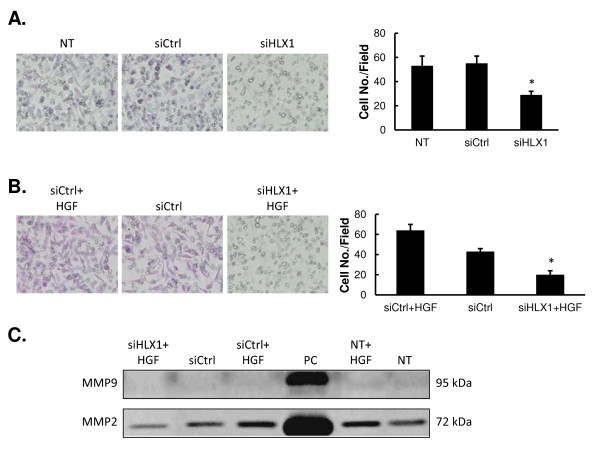
Targeting HLX1 reduces the cell invasion and the production of MMP2 in response to HGF. (A) HTR-8/SVneo cells were either not transfected (NT), or transfected with siCtrl or siHLX. The invasion of transfected cells across matrigel was determined by a transwell assay. Images of representative invasive cells are shown on the left, and quantifications are shown on the right. (B) HTR-8/SVneo cells were transfected with either siCtrl or siHLX1 and treated with or without 20 ng/mL HGF. The invasion of transfected cells across matrigel was determined by a transwell assay. Images of representative invasive cells are shown on the left, and quantifications are shown on the right. All quantitative data are presented as mean ± SD for three independent experiments. *P < 0.01, as compared to the other two groups. (C) HTR-8/SVneo cells were treated as indicated. The MMP2 and MMP9 levels in the conditioned medium from the cells were measured by gelatin zymography; conditioned medium collected from HT1080 cells were used as a positive control (PC).